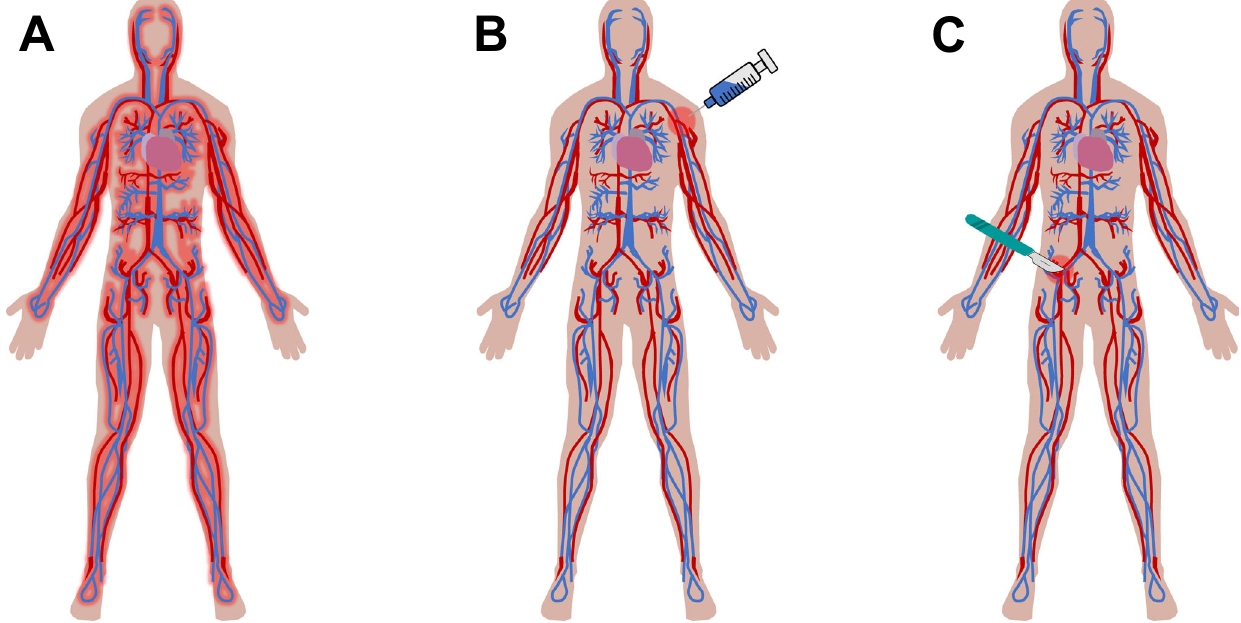
Fig. 2 Schematic of the circulatory system to depict different drug distribution effects from various administration methods. A Oral administration is the most common and simplest method for analgesic delivery to date, however, fi rst pass metabolism limits bioavailability to the active site and exposes even healthy tissue to the drug, therefore making it inef fi cient and uneconomical. Both ( B ) injectable (mainly subcutaneous or intramuscular) and ( C ) implantable controlled delivery methods afford a more localized exposure of the drug when administered, especially when impregnated into a controlled release matrix. If implanted at the site of injury, therapeutic effects should stay localized to a radius relative to the site of insertion, which will depend on the system itself (i.e., drug solubility and